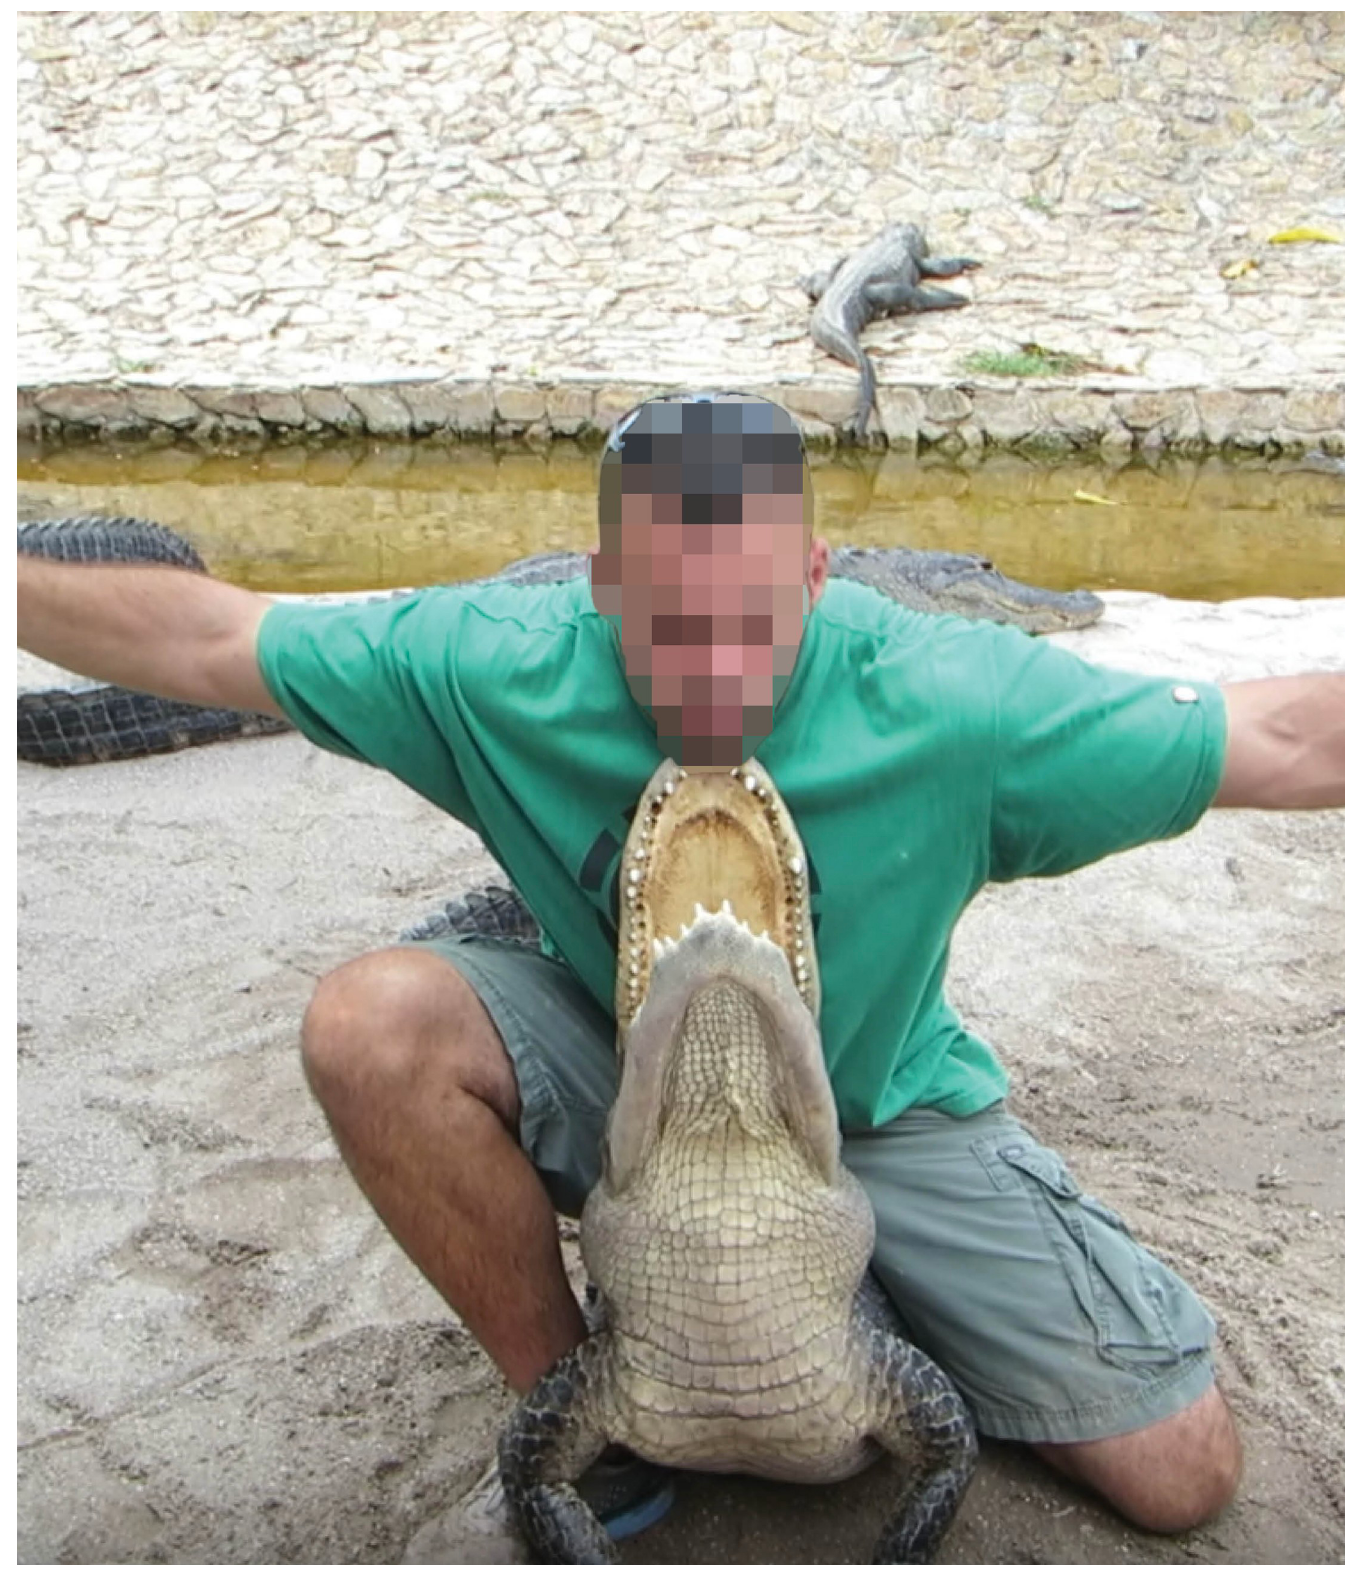
Fig 3. The “Face-off” stunt. Image captured from a video in the dataset. https://doi.org/10.1371/journal.pone.0242106.g003 PLOS ONE | https://doi.org/10.1371/journal.pone.0242106 November13,